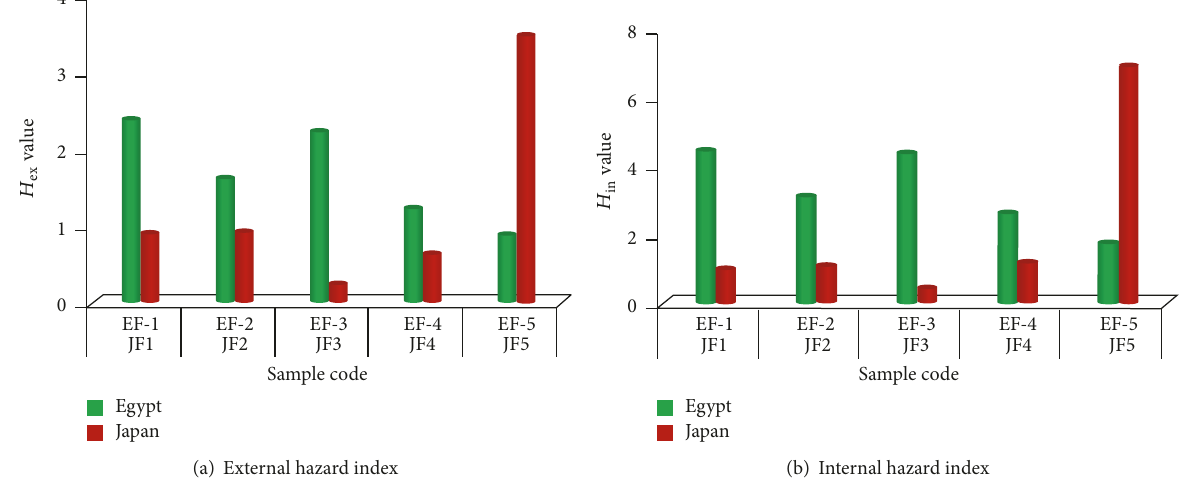
Figure 2: Comparison of external and internal indexes of Egyptian and Japanese fertilizers.